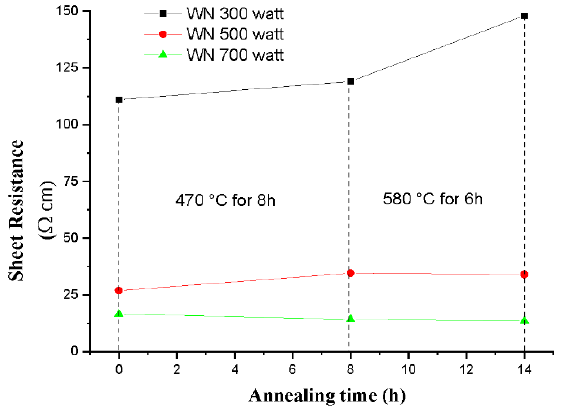
Figure 1. Sheet resistance versus annealing time.